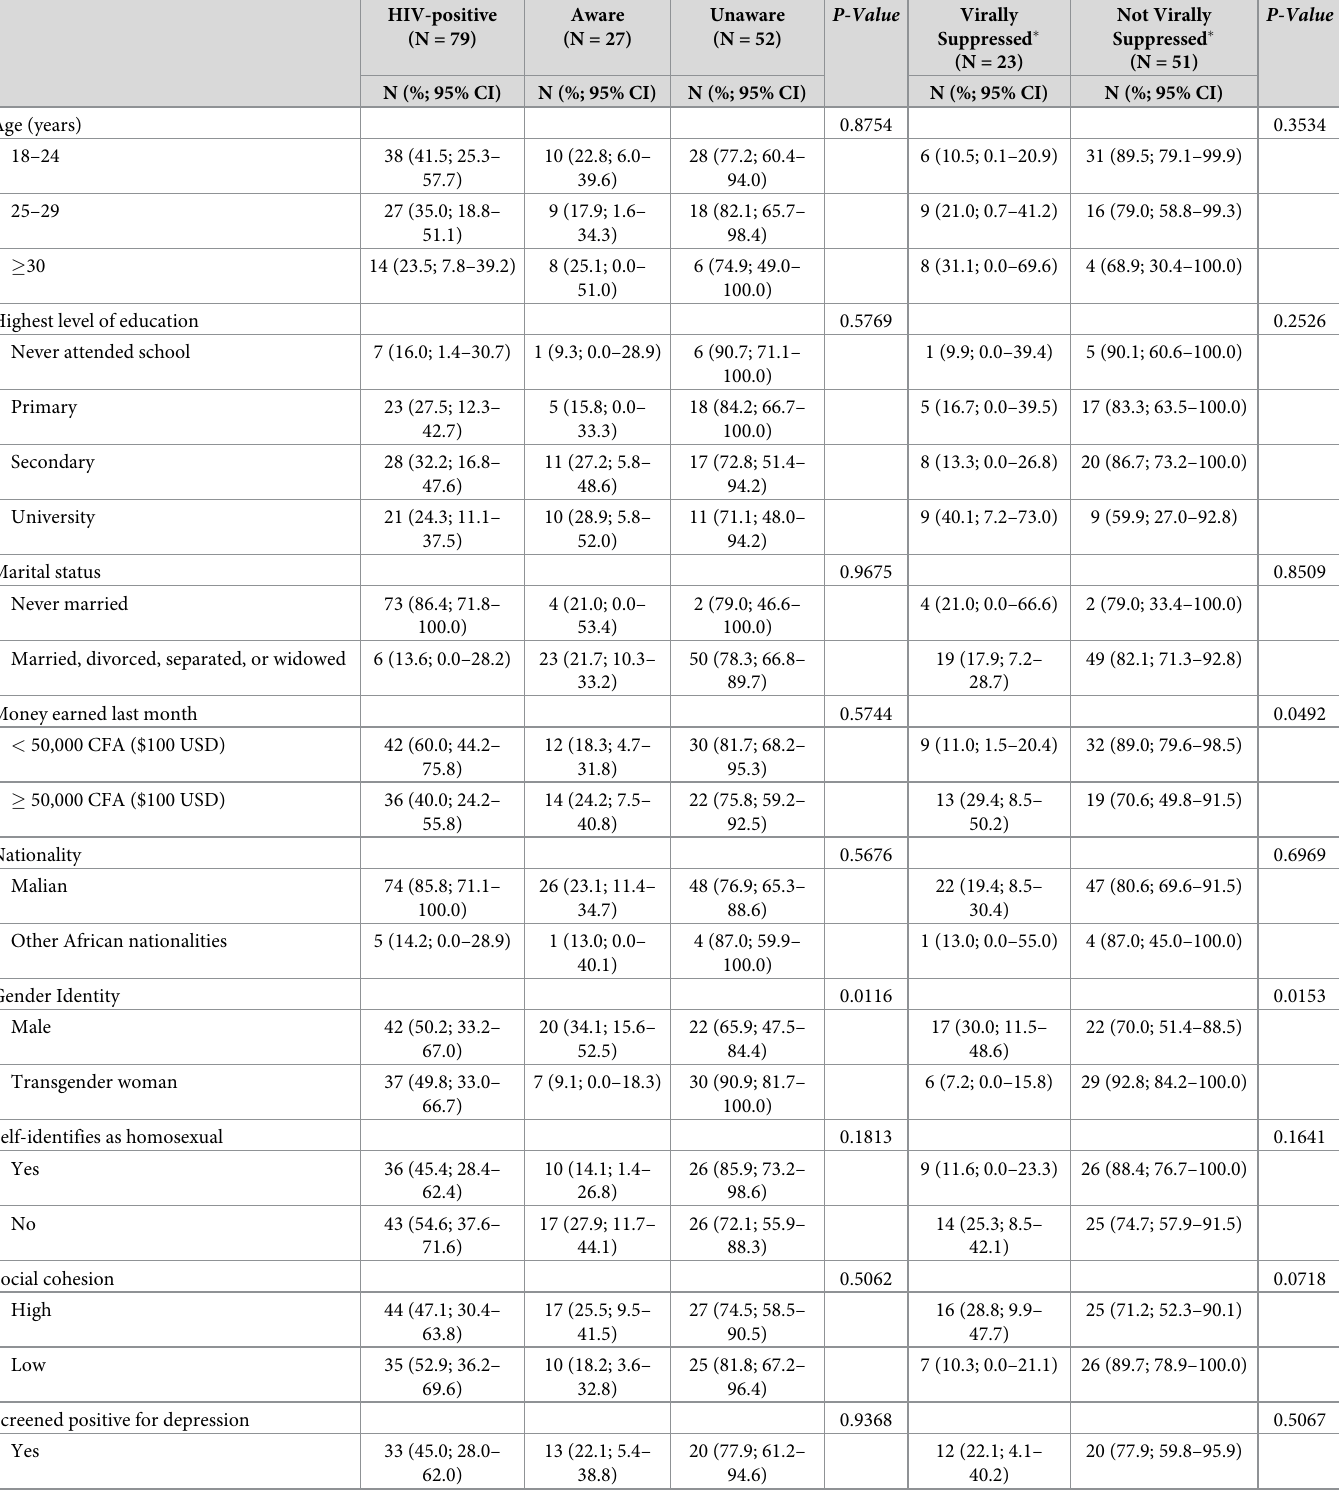
Table 1. Characteristics of HIV-positive MSM and TGW in Bamako, Mali based on awareness of HIV-positive status and viral load suppression status,